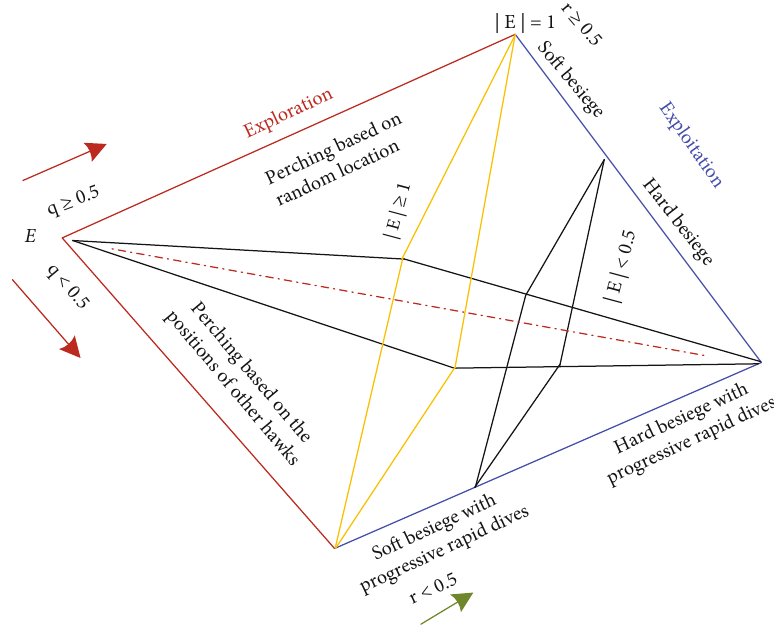
Figure 3: The Harris hawk optimization